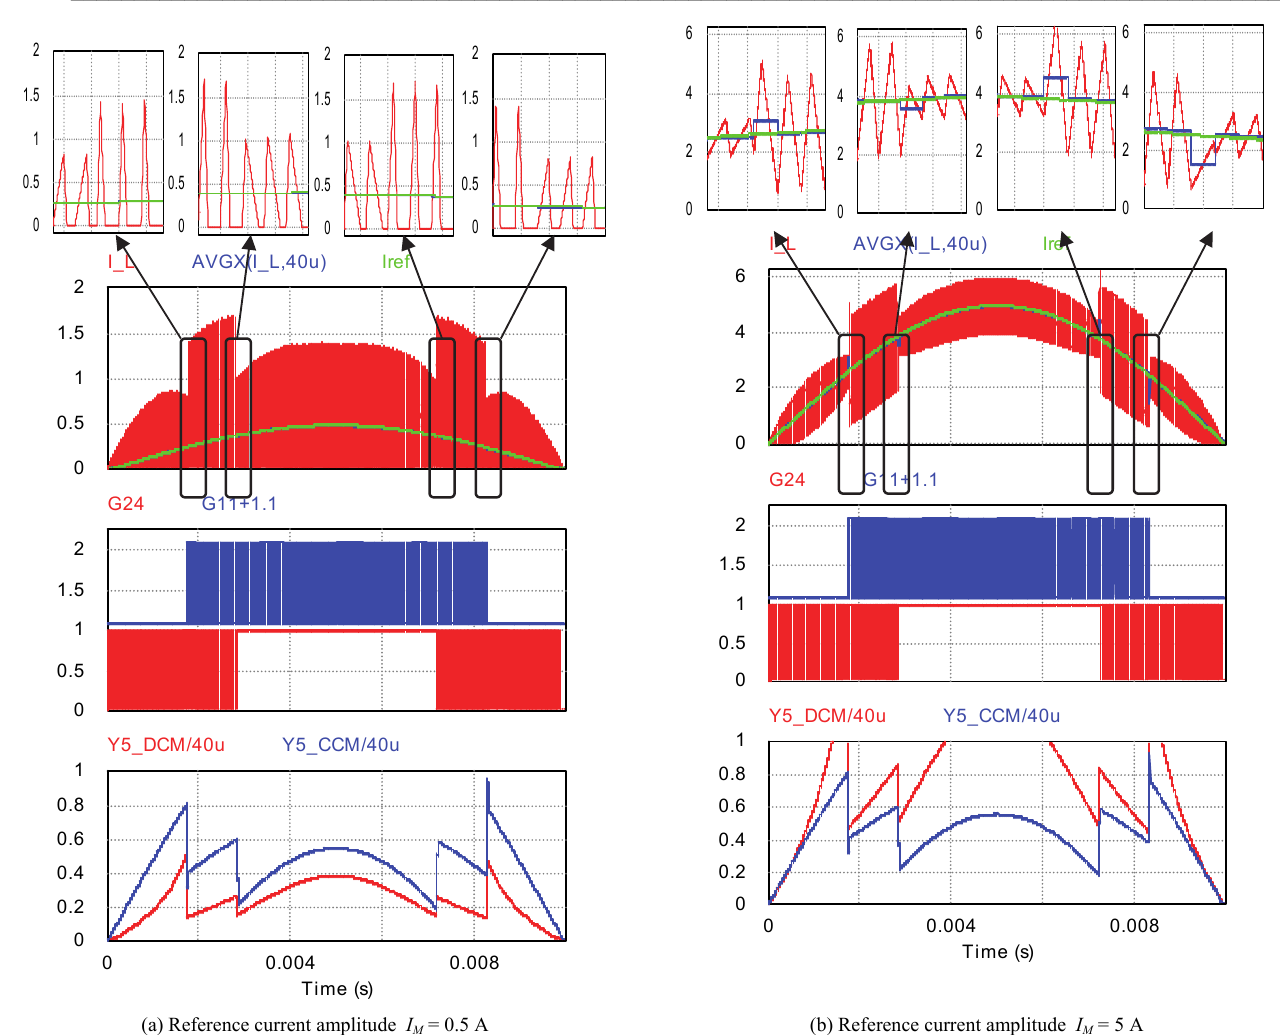
Fig. 5. Simulation results of CSC applied to NPC inverter during (a) DCM and (b) CCM operation (top graphs (I_L, AVGX(I_L,40u), Iref) consist of inductor’s current, average inductor current, reference current values; middle graphs (G24, G11+1.1) contain actively commutated switching signals; bottom graphs represent) calculated DCM and CCM duty cycle